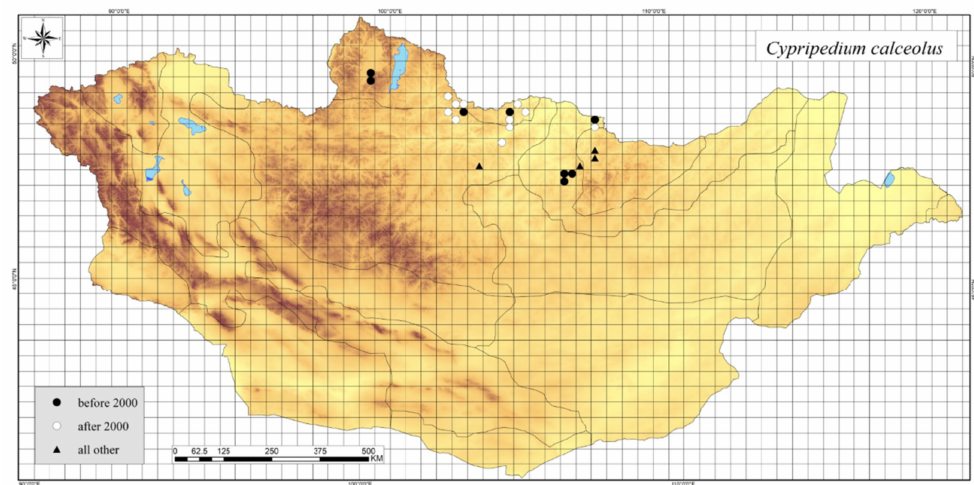
Figure A3. Distribution map of Cypripedium calceolus in Mongolia.